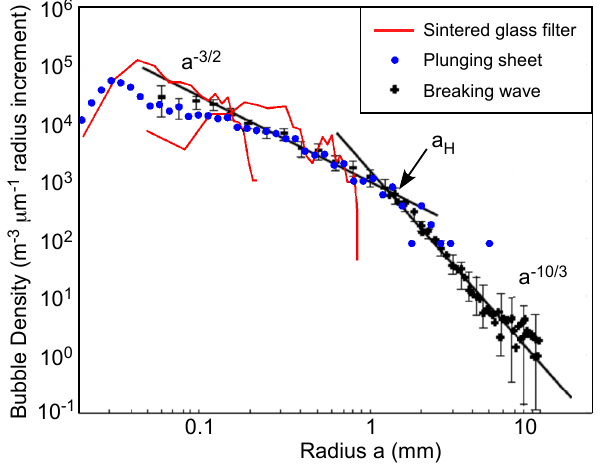
Fig. 4. Intercomparison of bubble size distributions from a labora- tory breaking wave, the plunging sheet in the MART system and two distributions from sintered glass filters. The breaking wave dis- tribution is in absolute units; the plunging sheet and sintered glass filter bubble distributions have been scaled as described in the text. The error bars on the breaking wave distribution show one std dev from a sample of 225 images from 14 breaking events (Deane and Stokes,